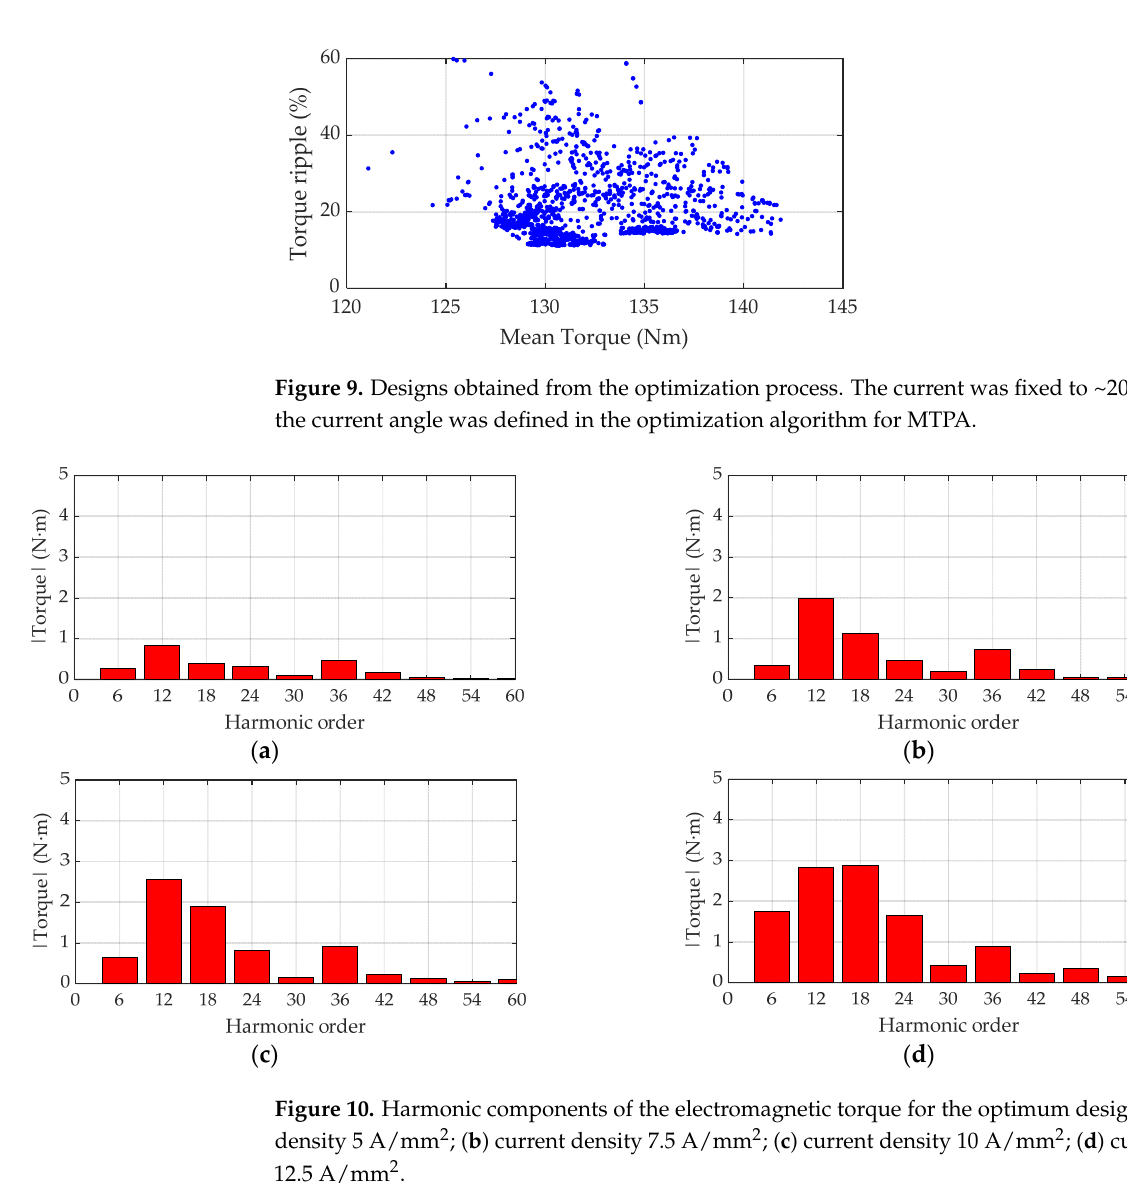
Figure 10. Harmonic components of the electromagnetic torque for the optimum design: ( a ) current density 5 A/mm 2 ; ( b ) current density 7.5 A/mm 2 ; ( c ) current density 10 A/mm 2 ; ( d ) current density 12.5 A/mm 2 .